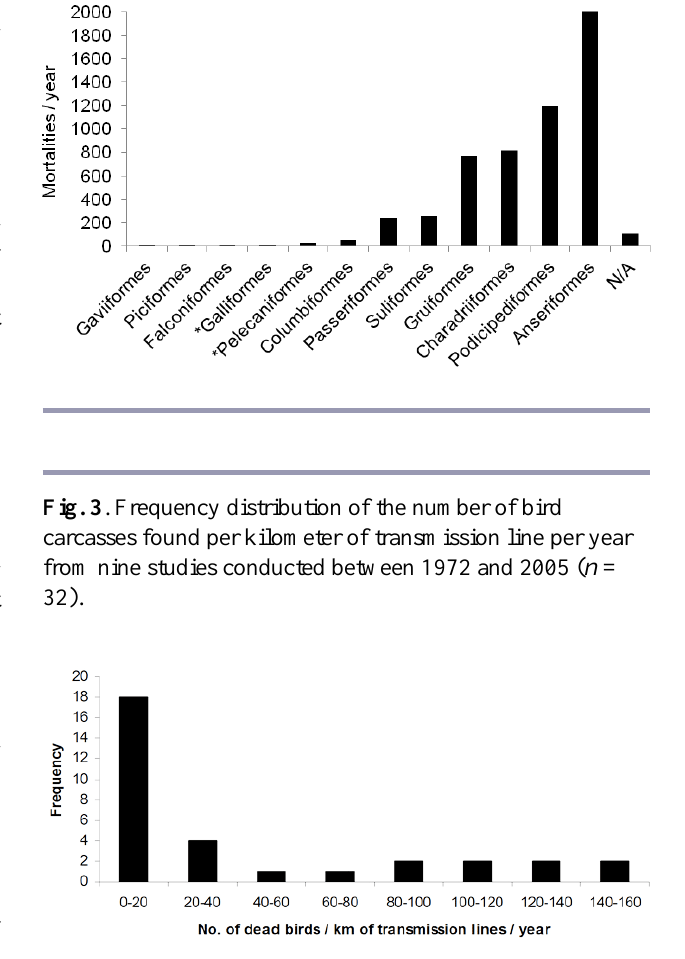
Fig. 2 . Relative frequency of avian mortalities due to collisions with transmission lines in Canada (Anderson